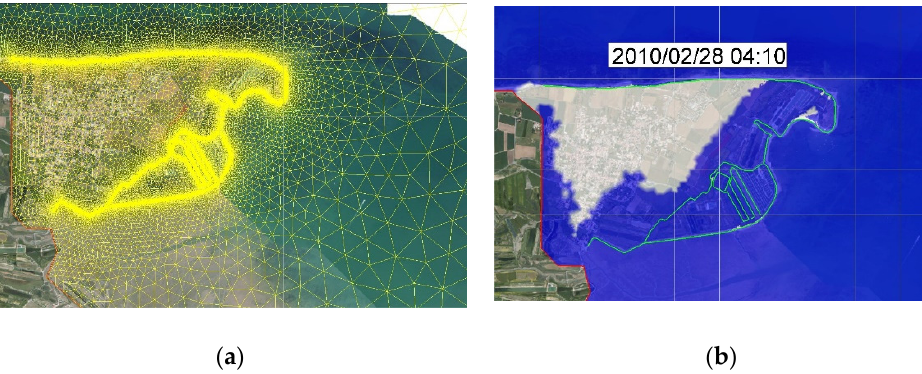
Figure 10. Loix hydraulic model ( a ) model grid; ( b ) output result of the model at a given time.